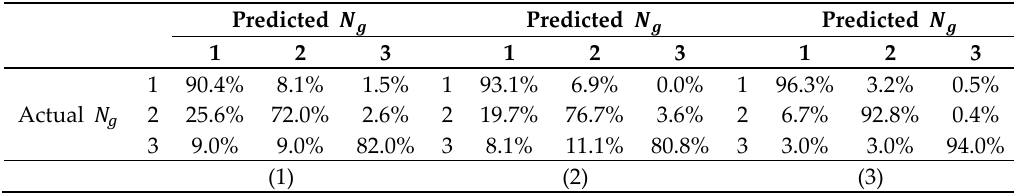
Table 3. Performances obtained using the steady state amplitude (1), the MSE errors (2) and the concatenation of the two feature spaces